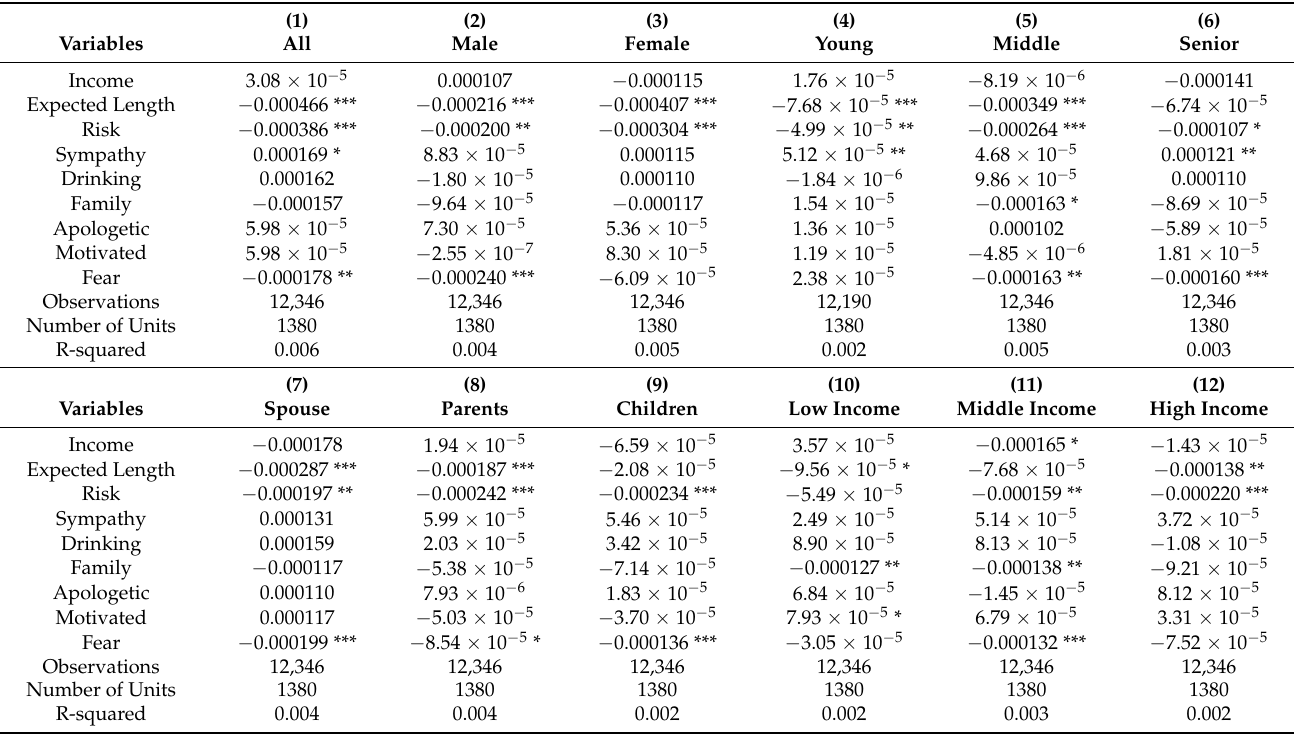
Table 3. Estimation results for full